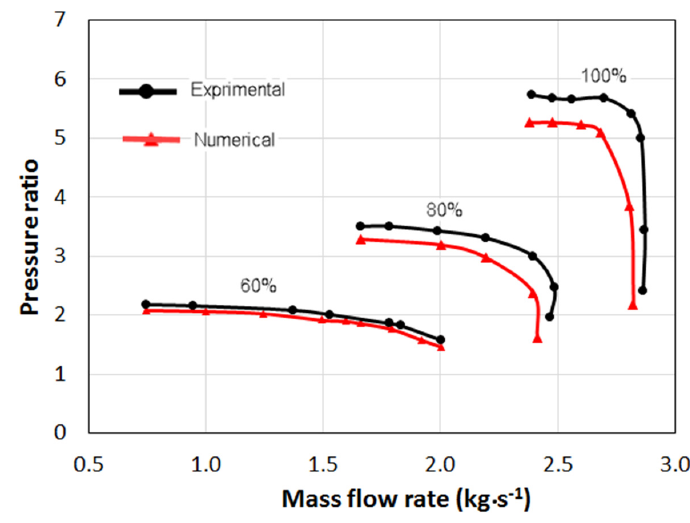
Figure 5 . Numerical model validation. Figure 5. Numerical model validation.